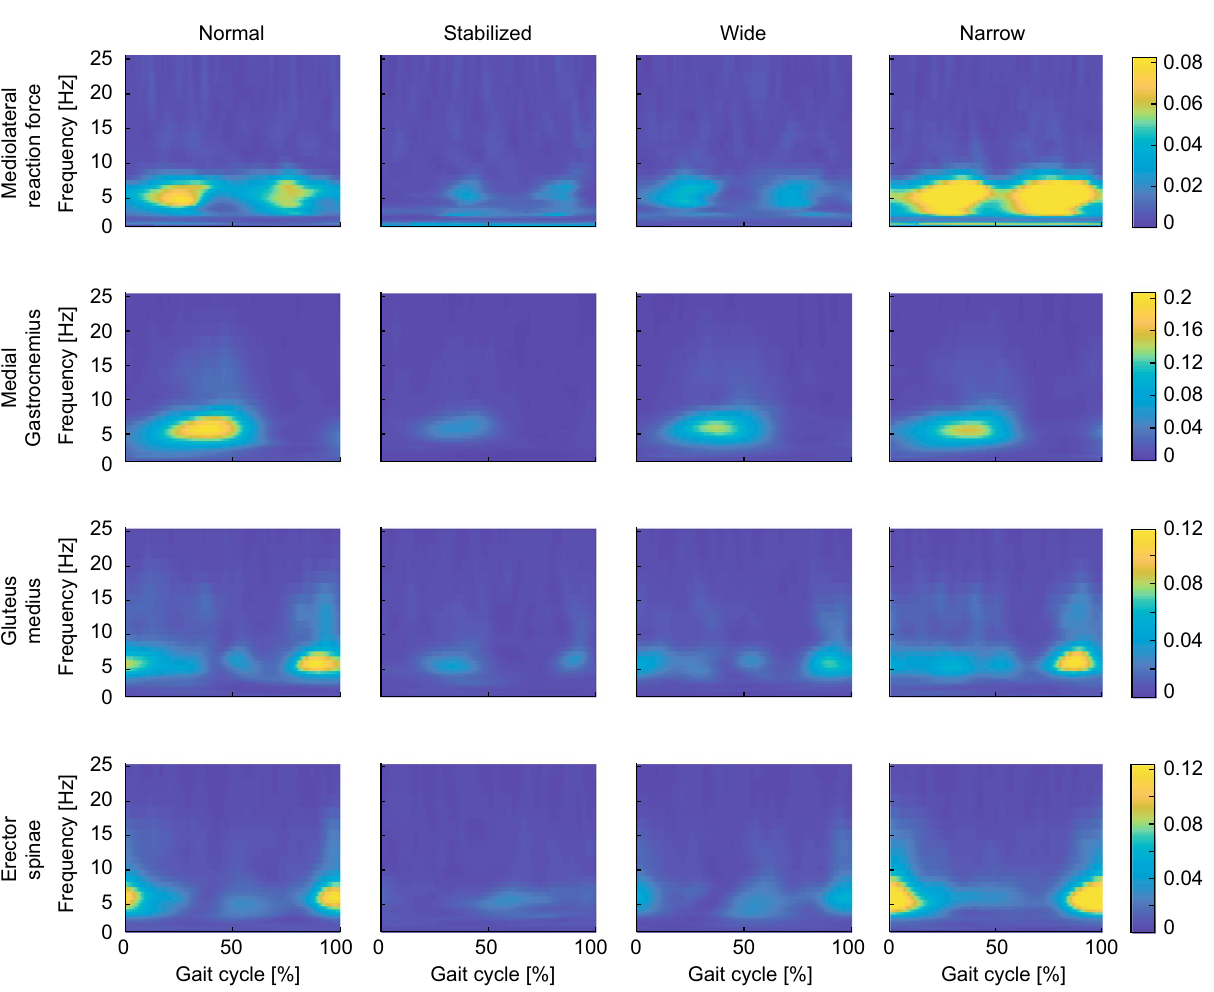
Figure 4. Coherence plots of EVS-GRF (first row) and EVS-EMG for medial gastrocnemius (second row), gluteus medius (third row) and erector spinae (fourth row) for normal walking (first column), walking with external stabilization (second column), wide-base walking (third column) and narrow-base walking (fourth column). Coherence magnitude is indicated by the color